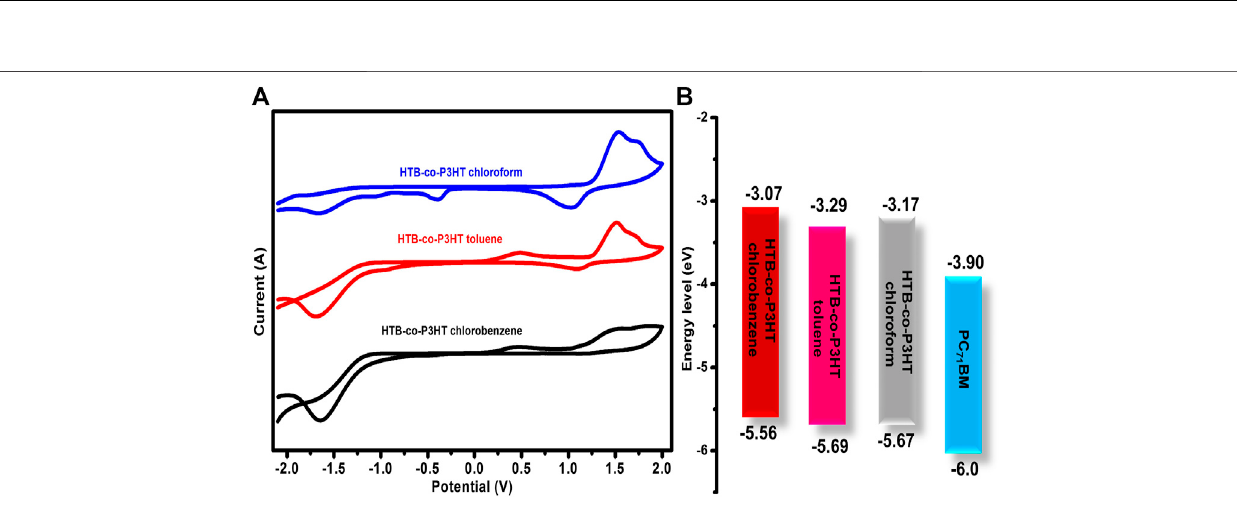
Frontiers in Materials |